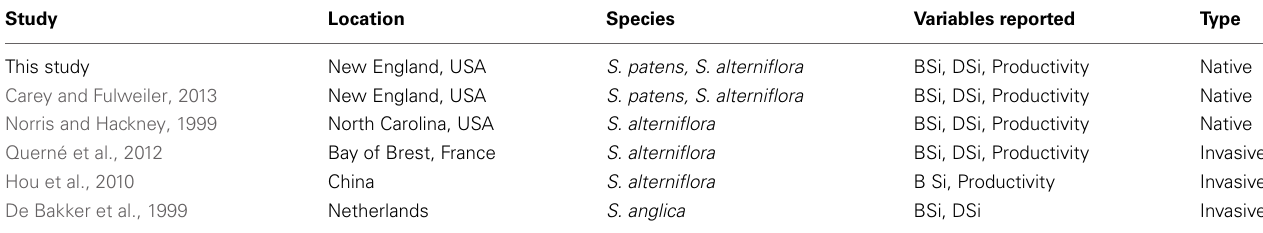
Variables reported: DSi indicates porewater DSi (SiO 2 ) concentrations, BSi indicates aboveground tissue plant BSi concentrations. Productivity indicates biomass per unit area.